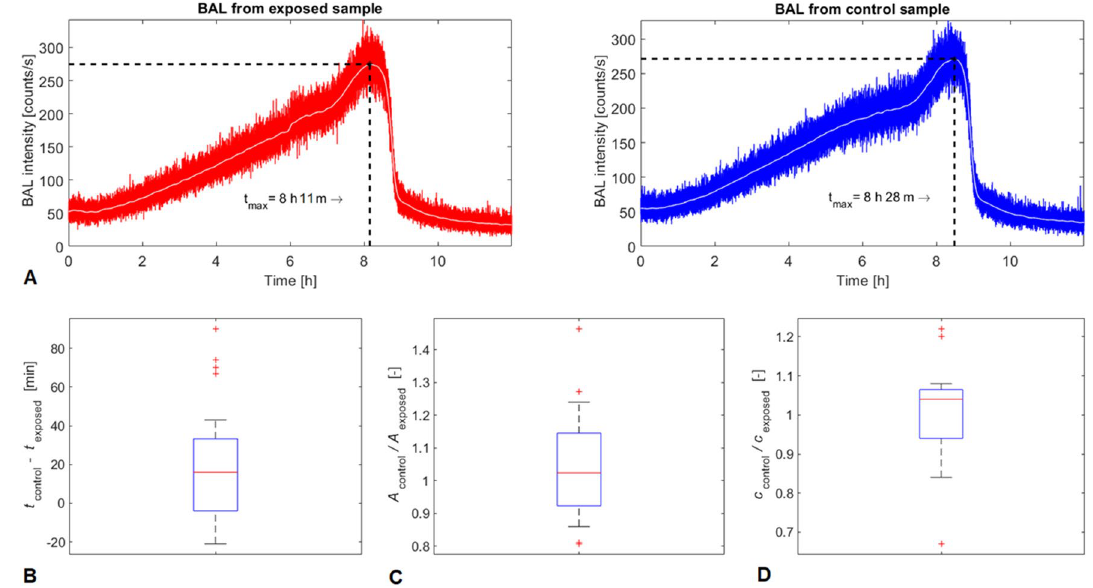
Figure 6. BAL monitoring and cell concentration in yeast cell culture exposed to low-frequency magnetic field. ( A ) The representative shape of BAL dynamics from magnetic field exposed and control sample of yeast cells. ( B ) Boxplot of time differences of BAL maxima reaching between exposed and control sample ( t control − t exposed ) shows that the maximum tends to occur earlier in exposed samples ( p = 0.039 ). ( C ) Boxplot of ratios of BAL maxima intensities ( A control / A exposed ). ( D ) Boxplot of ratios of cell concentrations measured at the time of 6 h ( c control / c exposed